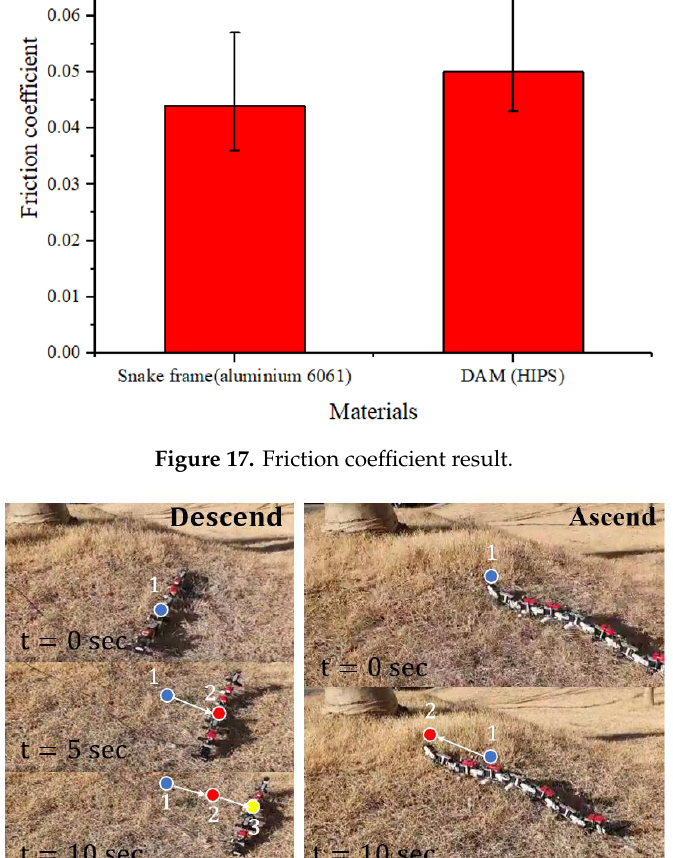
Figure 20. Performance of the ascending motion without the DAM.